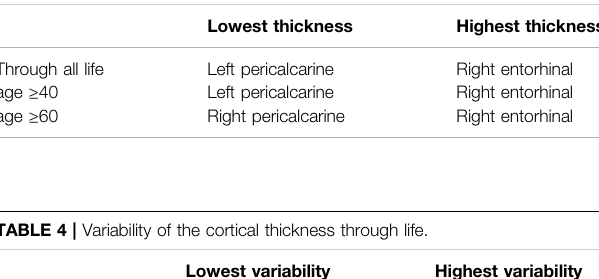
TABLE 3 | Modeling of the cortical thickness through life.